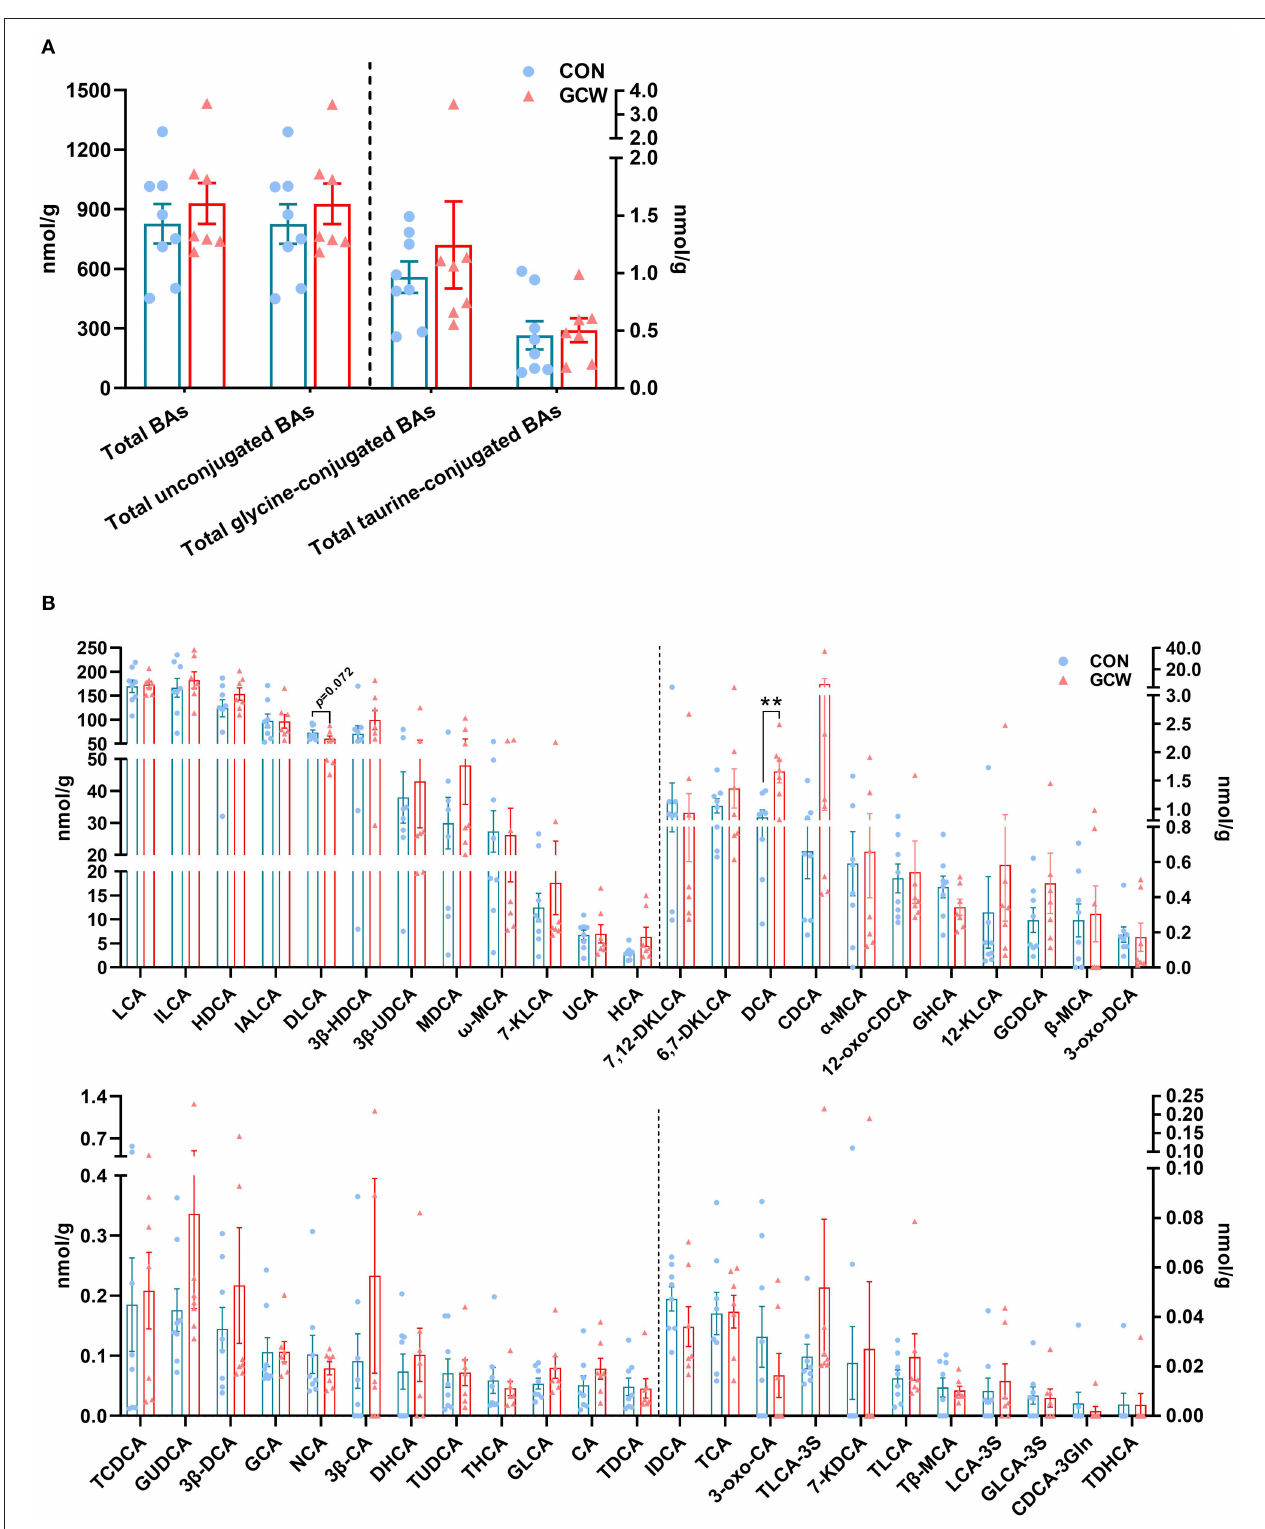
FIGURE 5 | Fecal bile acid composition between the two groups on day 109 of gestation. (A) Fecal total bile acids, total unconjugated bile acids, total glycine-conjugated bile acids, and total taurine-conjugated bile acids. (B) Fecal individual bile acids. Data are presented as means ± SEM ( n = 8 sows in the control group and 7 sows in the GCW group). ** p <